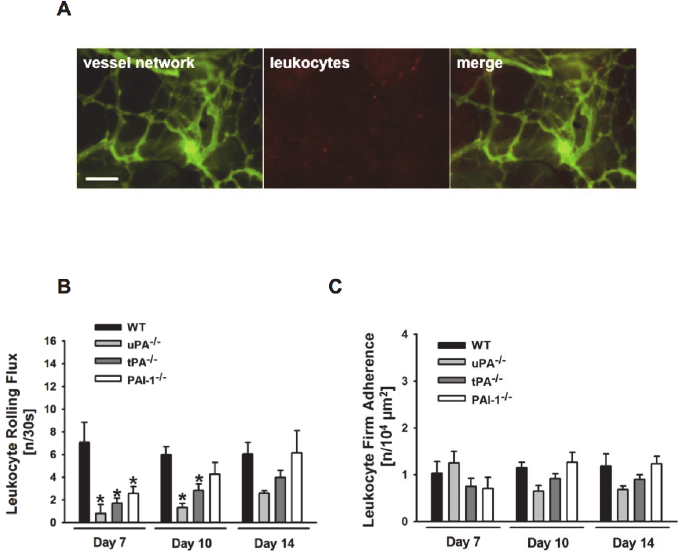
Figure 3. Role of endogenous uPA, tPA, and PAI-1 for leukocyte-endothelial cell interactions in PPE biomaterial. Interactions of fluorescence-labeled leukocytes and endothelial cells in newly formed microvessels within the PPE implants in WT as well as in uPA-, tPA-, or PAI-1-deficient mice were analyzed by in vivo fluorescence microscopy. Representative in vivo microscopy images of these processes in a WT mouse are shown ( A ; scale bar: 100 μ m). Panels show results for the number of intravascularly rolling ( B ) and adherent ( C ) leukocytes (mean ± SEM for n = 6; * p < 0.05 vs. WT).